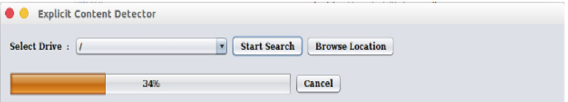
Figure 8: Searching progress of explicit content from the